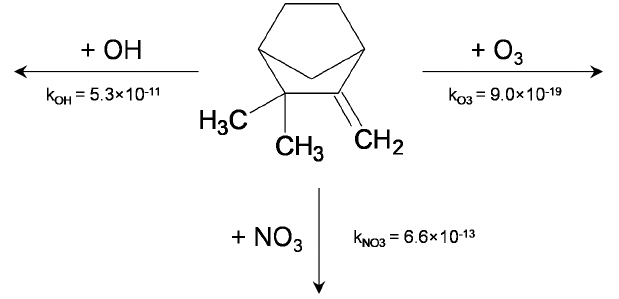
Figure 1. Camphene chemical structure and reaction rate constants (unit: cm 3 molec. − 1 s − 1 ) with major atmospheric